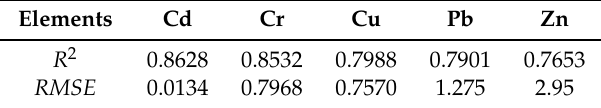
Table 5. The estimation results of the SMO-SVM model.